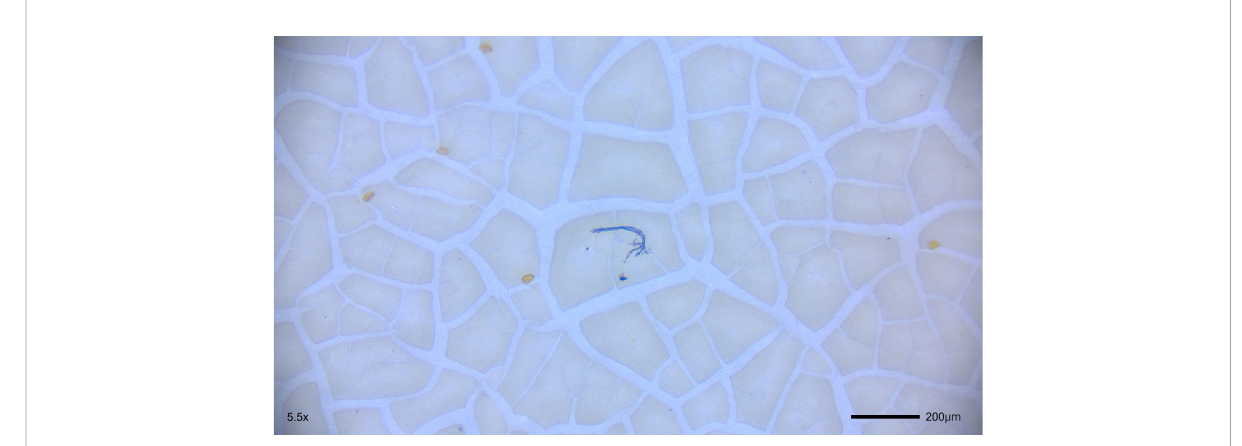
FIGURE 4 Example of Blue Fiber from a Gastric Sample of a Bottlenose Dolphin Sampled in Sarasota Bay, Florida (2019).